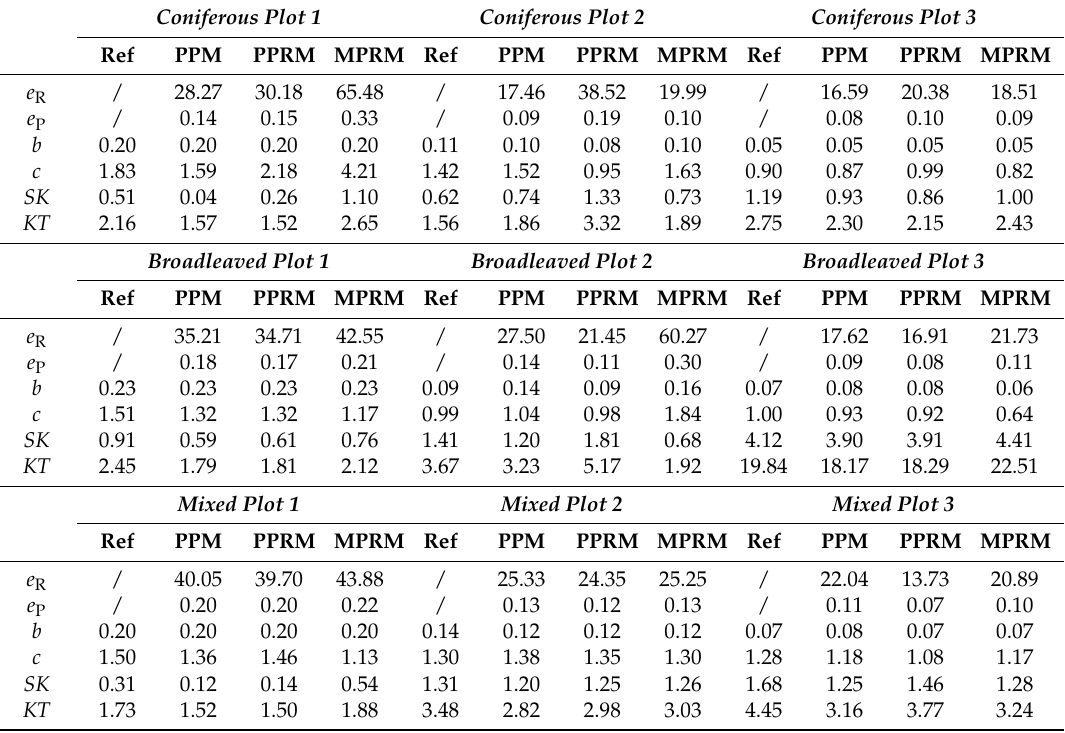
Table A5. The error indexes, Weibull parameters, skewness, and kurtosis of reference and predicted individual tree volume distributions for 9 sample plots. Coniferous Plot 1 Coniferous Plot 2 Coniferous Plot